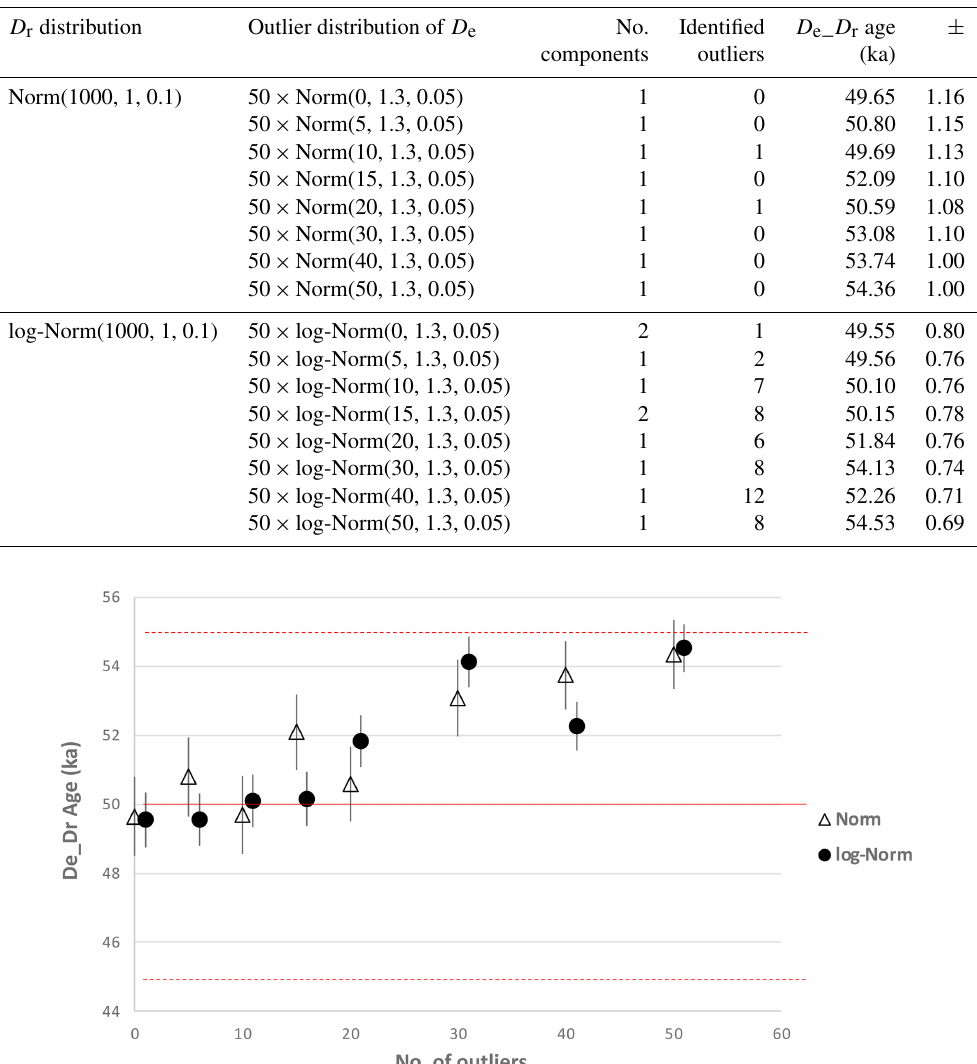
Table 3. For each type of D r distribution (normal or log-normal), outlier values were added following either the function 50 × Norm( n , 1.3, 0.05) or the function 50 × log-Norm( n , 1.3, 0.05). The number of outliers ( n ) varied from 0 to 50 (then representing between 0% and 33% of the initial D e distribution). The age error is the 95% credible interval.